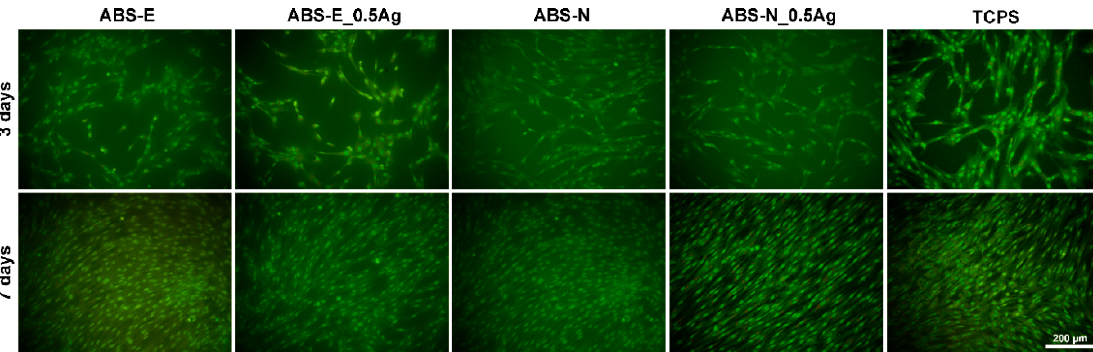
Figure 9. Fluorescence microscope images of Hs680.Tr cells in direct contact with the tested materials. Magnification 20 × .